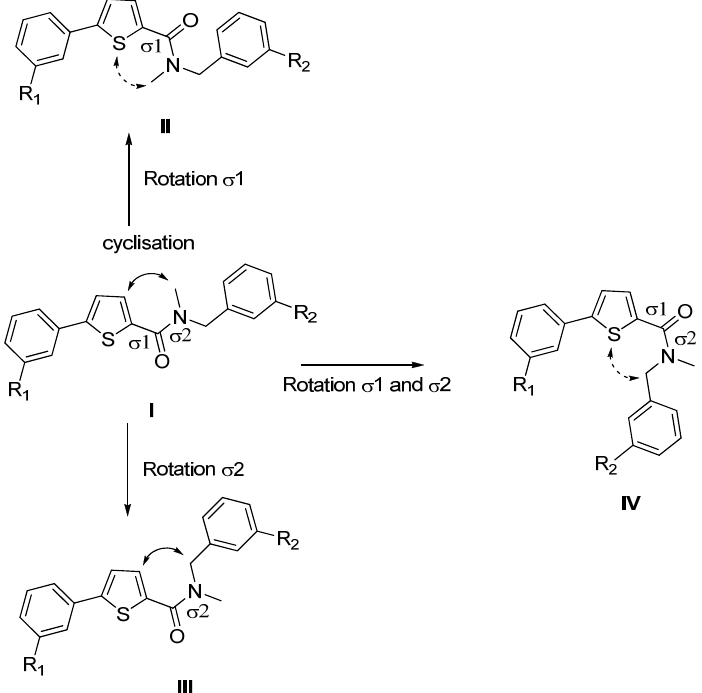
Figure 2. Four major conformers of thiophene-2-carboxamide derivatives A and B .